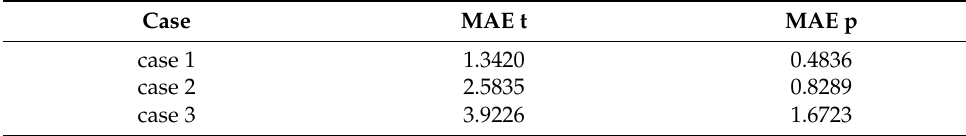
Table 3. MAE for three cases on the new data.